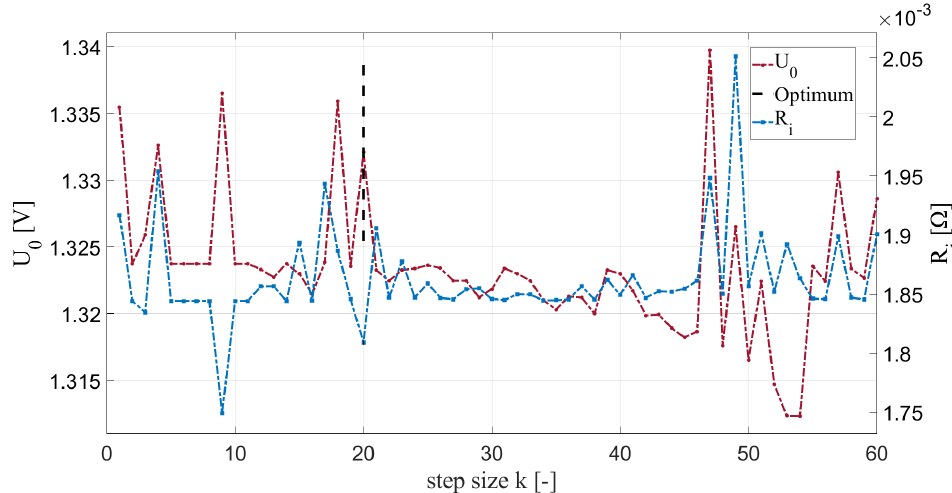
Figure 8. Third optimization step of U 0 and R i with preset step size of k =